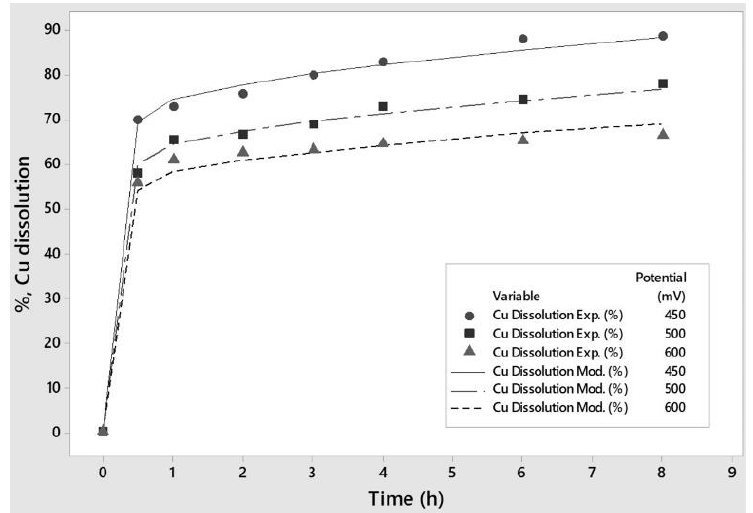
Figure 14. Experimental and modeled copper dissolution vs. time.